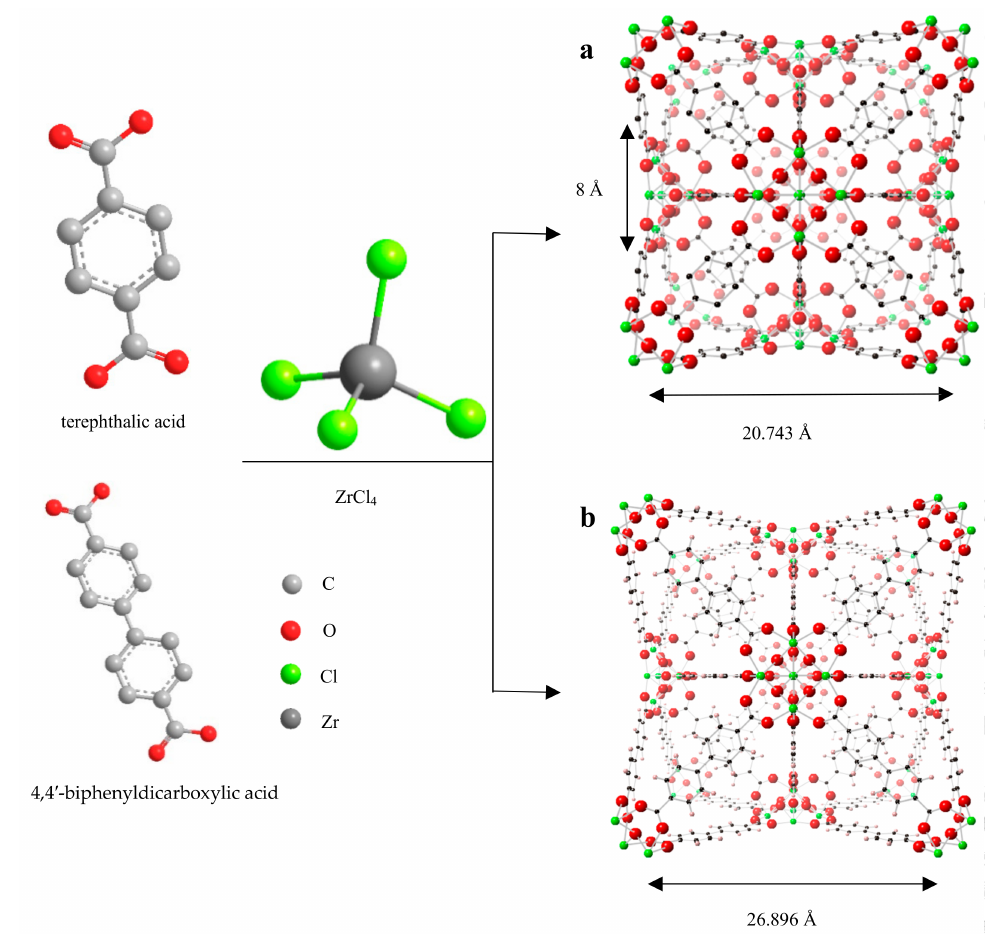
Figure 1. Fabrication of the UiOs. The structure of ( a ) UiO-66, ( b )